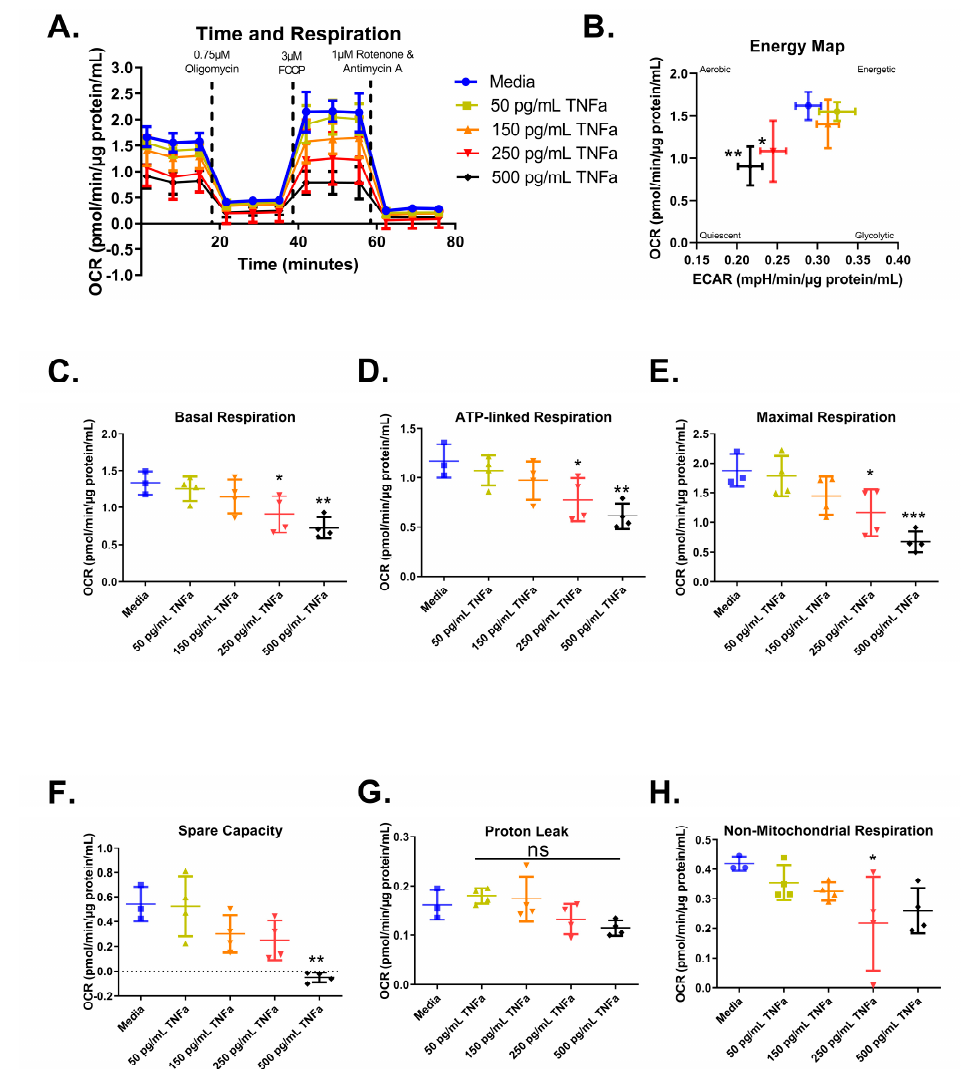
Figure 6. Normalized oxygen consumption rate for primary rat colon epithelial cells after 24 h exposure to TNF α . ( A ) Oxygen consumption rates over time, ( B ) energy map, ( C ) basal respiration, ( D ) oligomycin-induced ATP-linked respiration, ( E ) FCCP-induced maximal respiration, ( F ) spare capacity, ( G ) proton leak, and ( H ) non-mitochondrial respiration. Data are presented as mean ± standard deviation. Asterisks indicate degree of significance from medium control (One-way ANOVA followed by a Dunnett’s multiple comparison test, n = 3 or 4; significance determined at * = p < 0.05, ** = p < 0.01, *** = p < 0.001). NS = not significant.